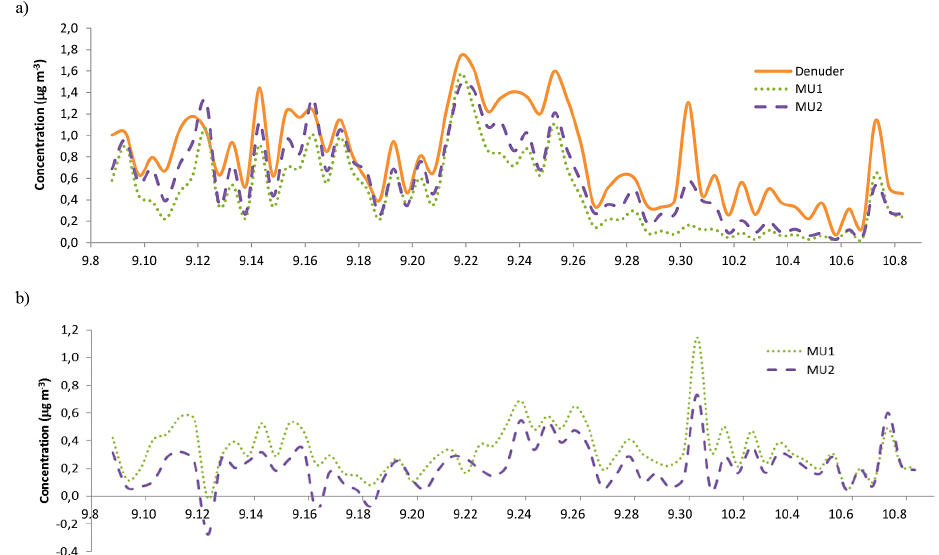
Figure 20. (a) Denuder and MU measured NH 3 concentrations (unadjusted for the external standard) during the ETV period. (b) Concen- tration difference (denuder minus MUs) between the denuder and MU NH 3 concentrations (unadjusted for the external